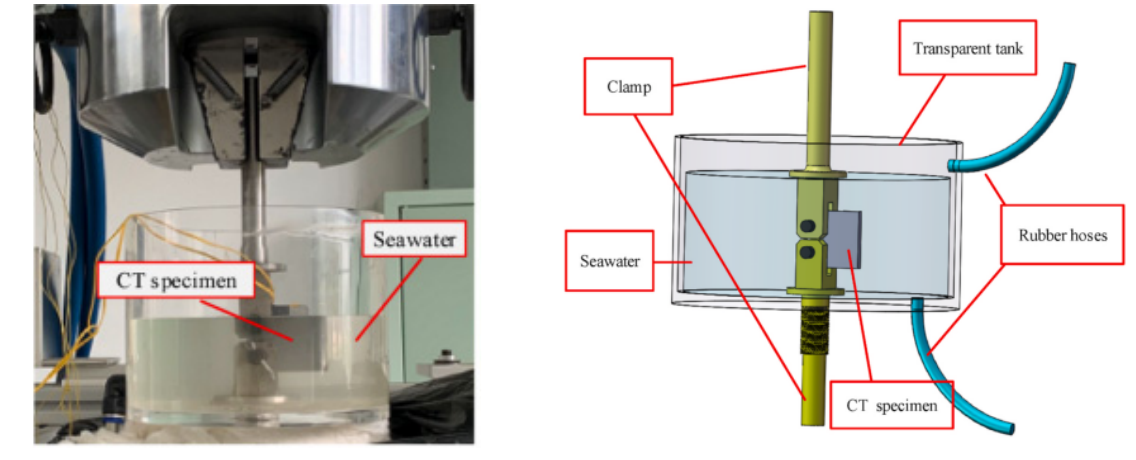
Figure 1. Corrosion fatigue test setup [5].